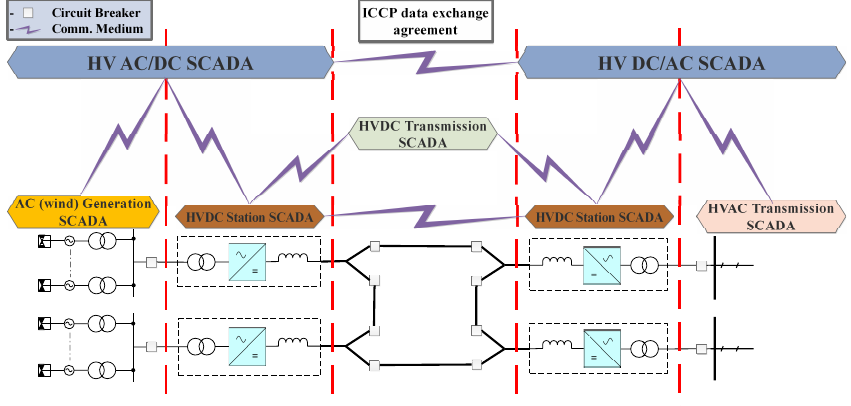
Figure 7. AC/DC SCADA: Multi-terminal network with multistage control stations [67].